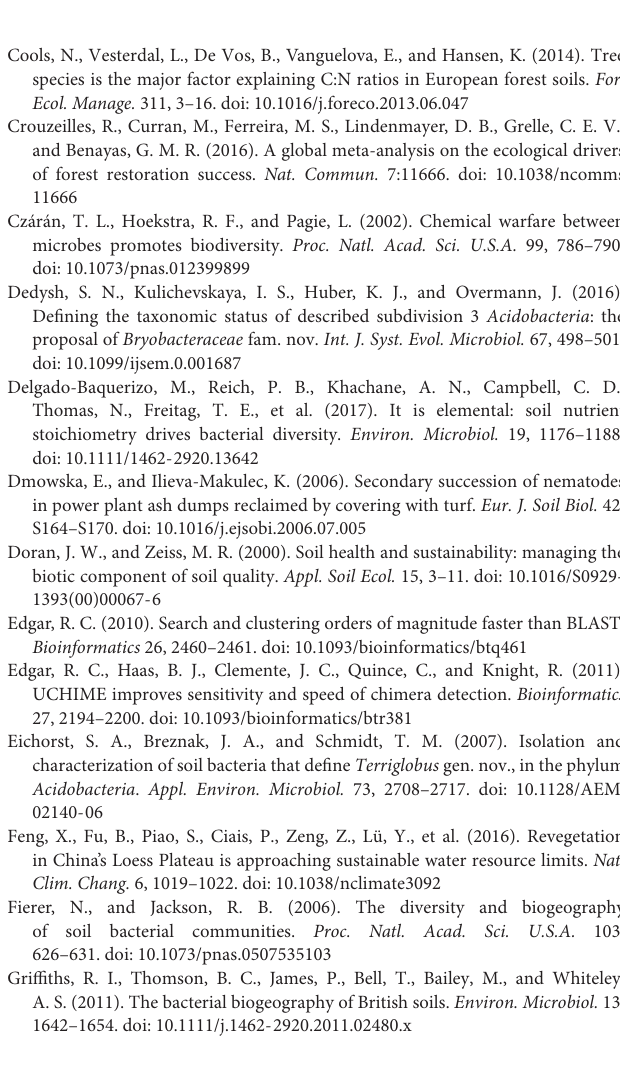
FIGURE S1 | Rarefaction analysis for each sample. FIGURE S2 | The proportion of the bacterial phyla/subphyla under five vegetation types. The phylum Proteobacteria contains the four subphyla of Alphaproteobacteria, Betaproteobacteria, Deltaproteobacteria and Gammaproteobacteria. G, Grassland; S shrubbery; SF, secondary forest; MP, mixed plantation; PP, pure